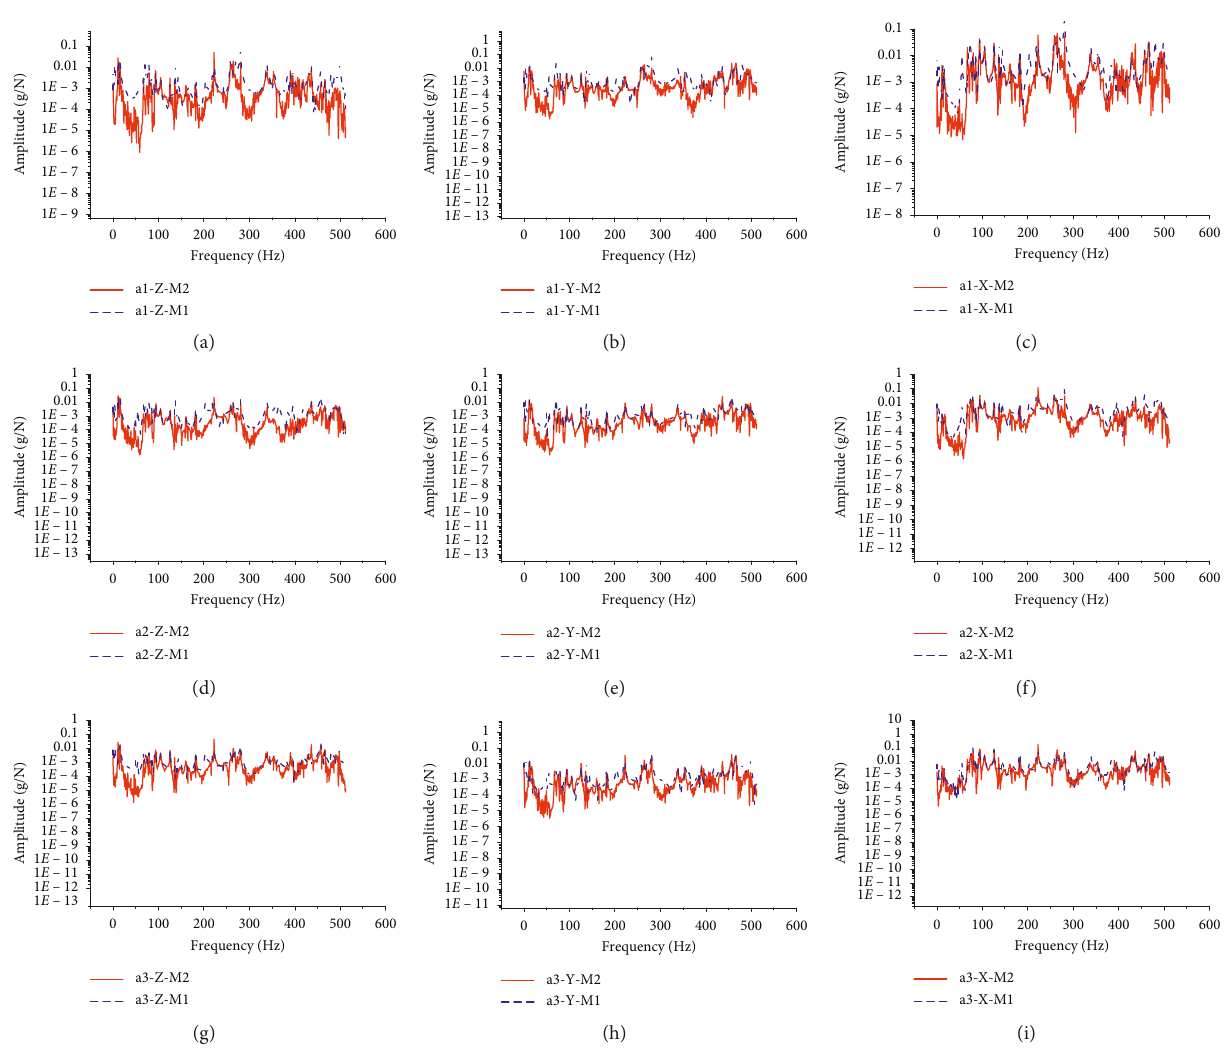
Figure 10: 2–4 s time section, point O ( a )3( ω ) , in the Z direction. Nine paths of { H s,c ( a ) c ( b ) ( ω ) 2 } calculated using M-2 compared to nine static paths of { H